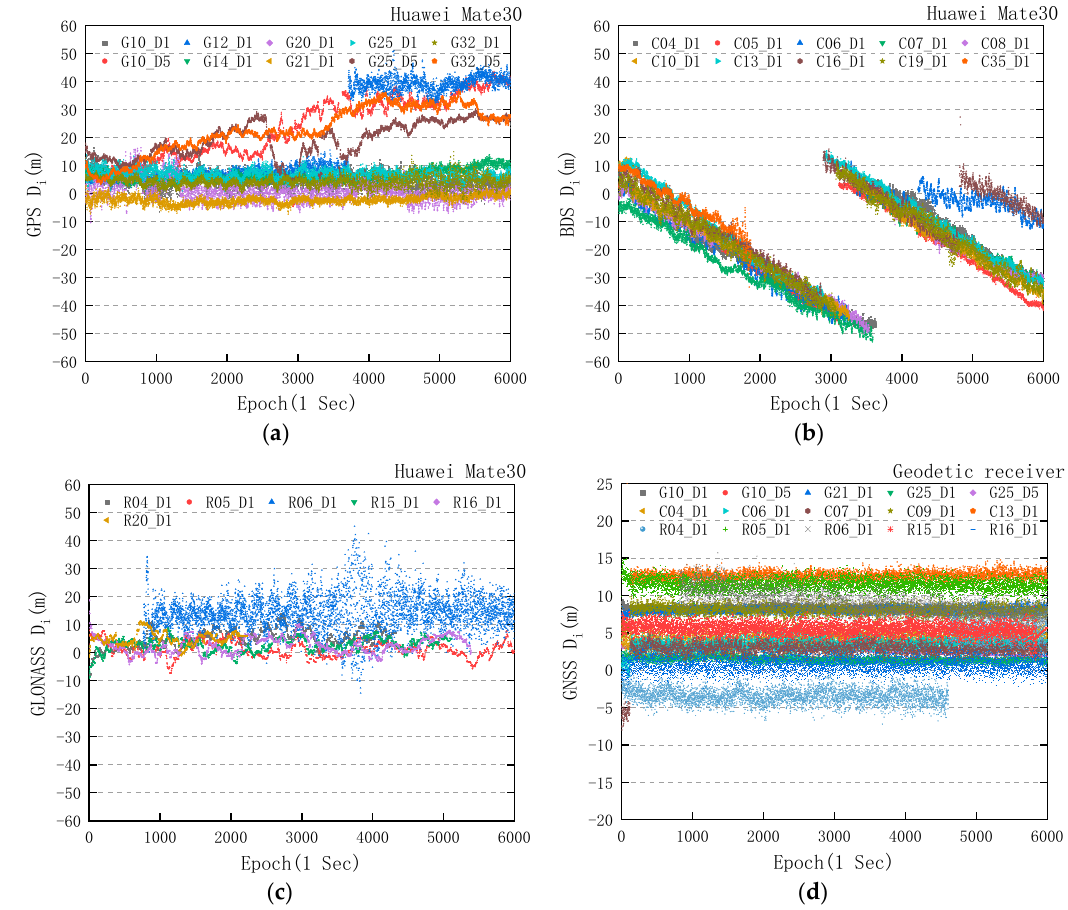
D of observed GPS, BDS, and GLONASS satellites in static data collected by Figure 4. Difference Figure 4. Di ff erence D i of observed GPS, BDS, and GLONASS satellites in static data collected by the i Huawei Mate30 and geodetic receiver. ( a ) Huawei Mate30 di ff erence D i of GPS; ( b ) Huawei Mate30 the Huawei Mate30 and geodetic receiver. ( a ) Huawei Mate30 difference di ff erence D i of BDS; ( c ) Huawei Mate30 di ff erence D i of GLONASS; and ( d ) geodetic receiver di ff erence D of BDS; ( c ) Huawei Mate30 difference Mate30 difference i D i of GPS, BDS, and D of GPS, BDS, and GLONASS. receiver difference i